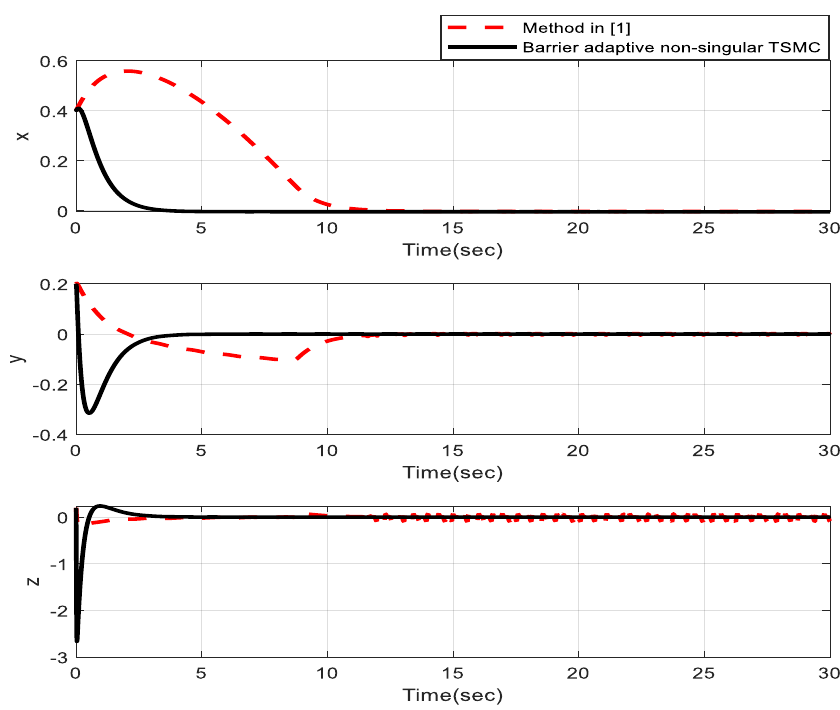
Figure 2. Trajectory stability of the state of system.